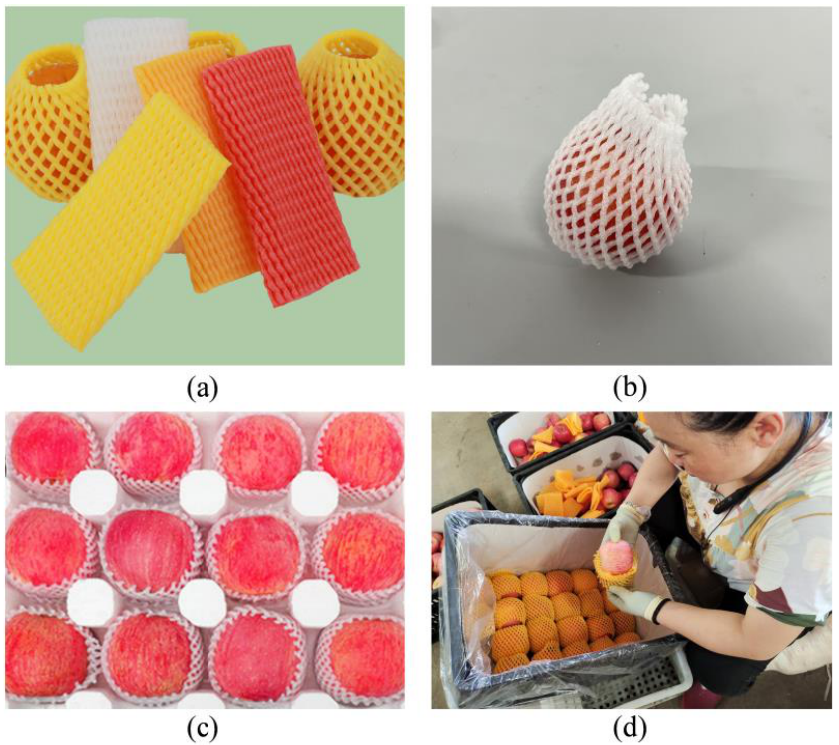
Figure 1. ( a ) Diagram of foam net sleeve; ( b ) Apple vertical release of the net sleeve packaging form; ( c ) Apple side release of the net sleeve packaging form; ( d ) Traditional manual completion of apple net sleeve packaging.